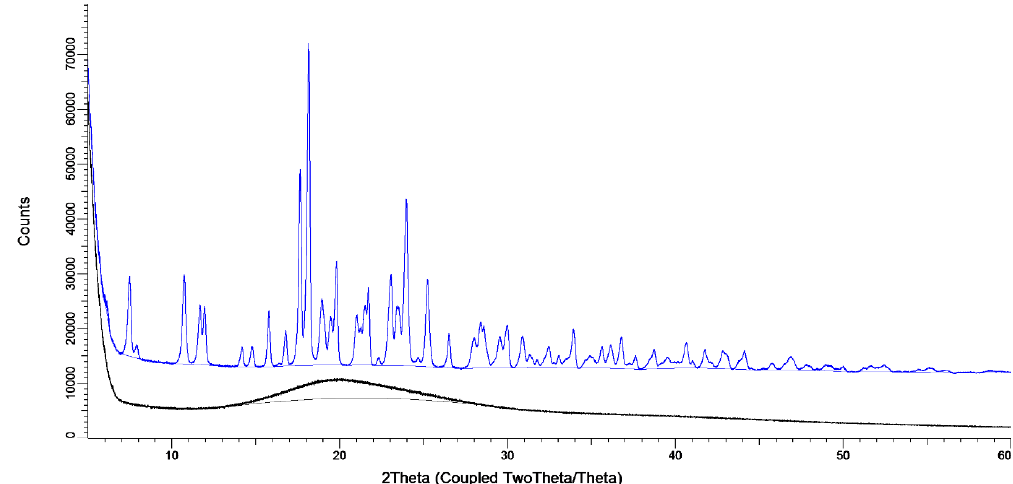
Figure 5. The X-ray spectra of the amikacin 1% L-leucine samples. The black line is the amikacin sample stored at 0% RH and the blue line is an amikacin sample stored at 80% RH for one week and is offset by 10,000 counts.